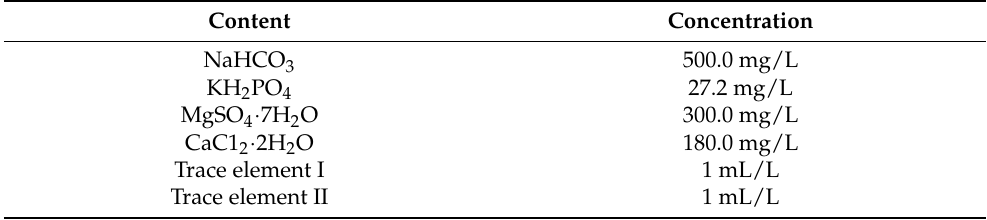
Table 1. Concentrations of synthetic sewage contents.